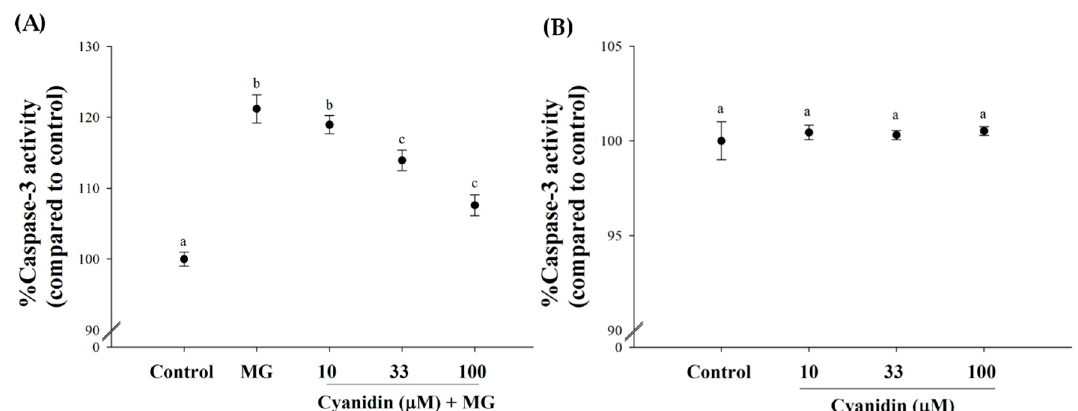
Figure 5. Effect of cotreatment of cyanidin and 500 µM methylglyoxal (MG) for 12 h on caspase-3 activity. ( A ) Cyanidin (33–100 µM) decreased MG-induced increase in caspase-3 activity. ( B ) Cyanidin